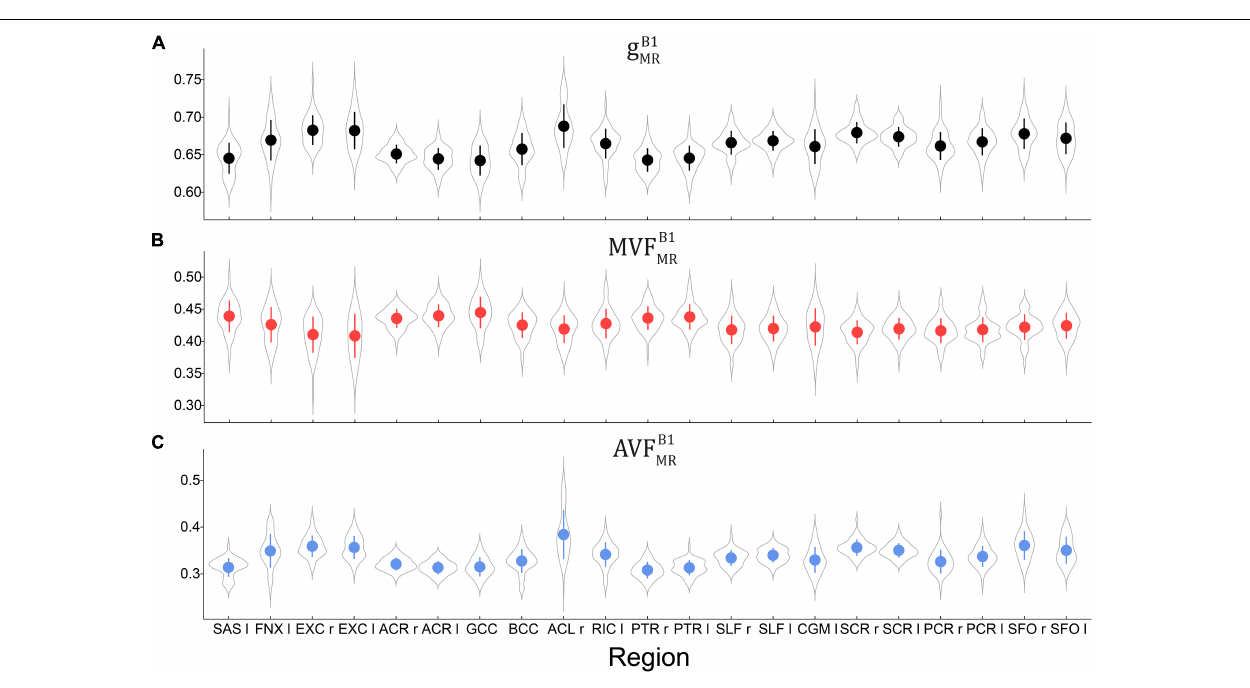
FIGURE 6 | Violin plots representing the distribution of g B1 MR (A) , MVF B1 MR (B) , and AVF B1 MR (C) across the group and in 21 high-SNR ROIs listed in Table 1 . The mean and standard deviation of the distribution are indicated by solid dot and whiskers, respectively.